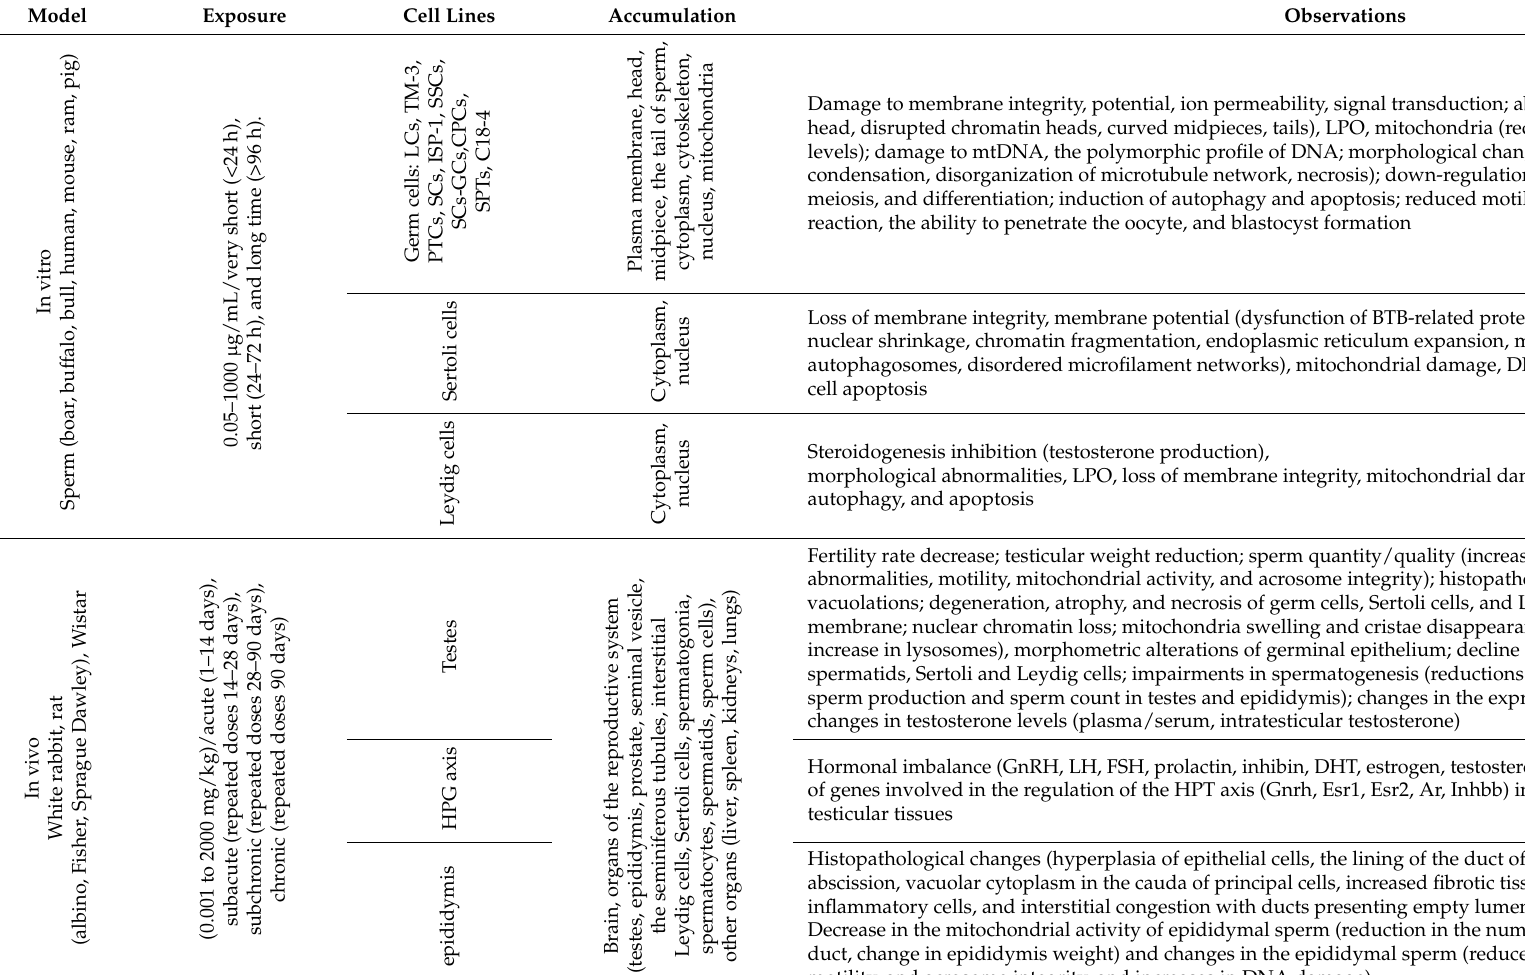
Table 3. Influence of NPs on the male reproduction system. Based on Refs. [228–230]. Model Exposure Cell Lines Accumulation Observations